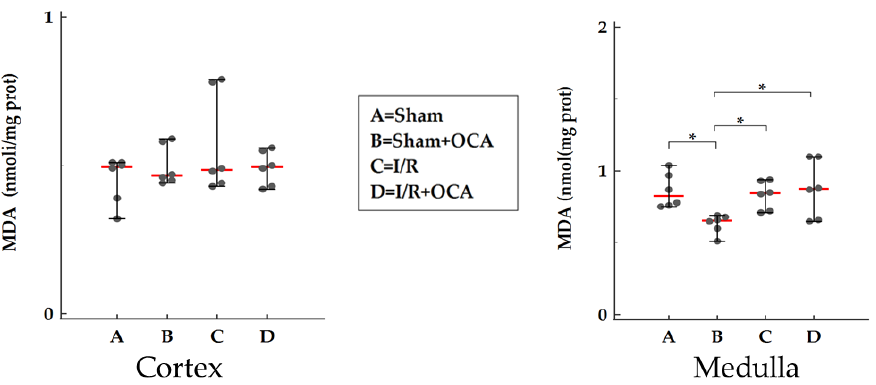
Figure 6. TBARS formation in kidney cortex and medulla in rats submitted to partial liver ischemia (60 min) followed by reperfusion (120 min). Animals were orally administered with OCA 10 mg/kg/day in methylcellulose 1% for 5 days ( n = 12) or with vehicle alone ( n = 12). Sham-operated animals were subjected to the same procedure without clamping the vessels. n = 6 rats/group. TBARS concentrations were calculated using malondialdehyde (MDA) as standard. Results are expressed as median value (red line) ± error bar (1–99 percentiles) (black dot). One-way ANOVA with Tukey–Kramer test (Medulla); Kruskal–Wallis test with Conover test (Cortex). * p < 0.05 versus I/R